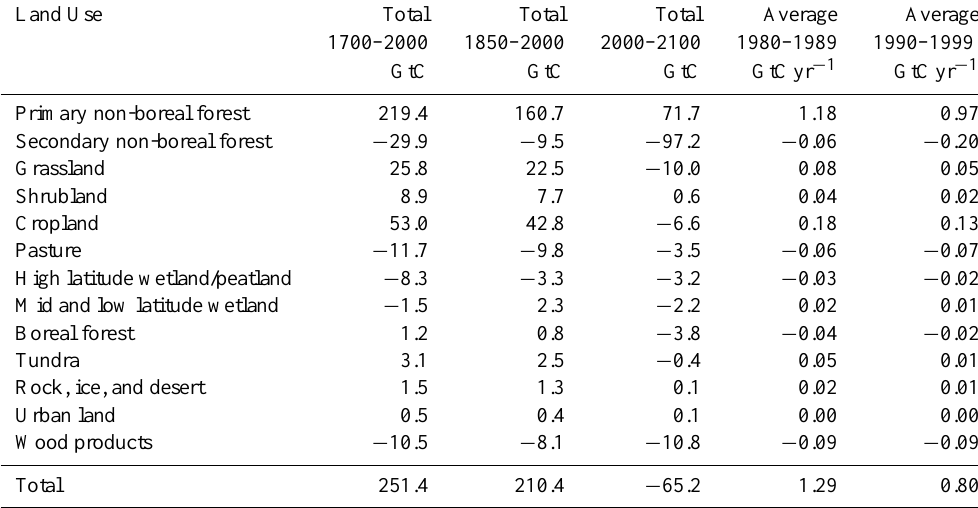
Table 3. Net land-use change emissions by ecosystem type (negative values indicate net uptake). Land